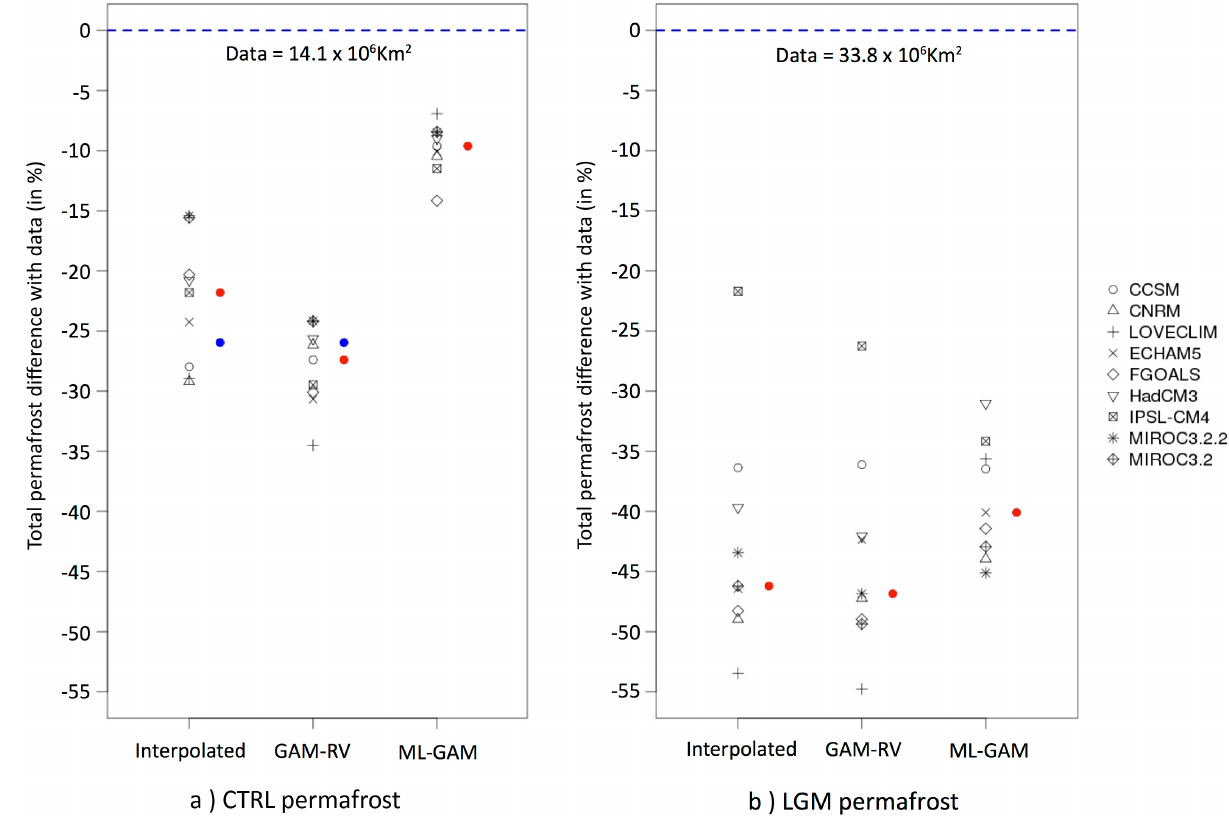
Fig. 5. Total permafrost area relative differences with data for CTRL (a) and LGM (b) periods. For each period, from left to right are the relative differences obtained from each method, respectively from: the interpolated PMIP2 models, the downscaled climate models by GAM- RV and the downscaled climate models by ML-GAM. For each case, the values of the nine models are shown by symbols with their median on the right (red bullets). For CTRL period, permafrost relative difference derived from CRU temperatures with the RV relationship is shown with blue bullets. IPA/FGDC (a) and Vandenberghe et al. (2011) (b) data are drawn with blue dashed lines, with their respective